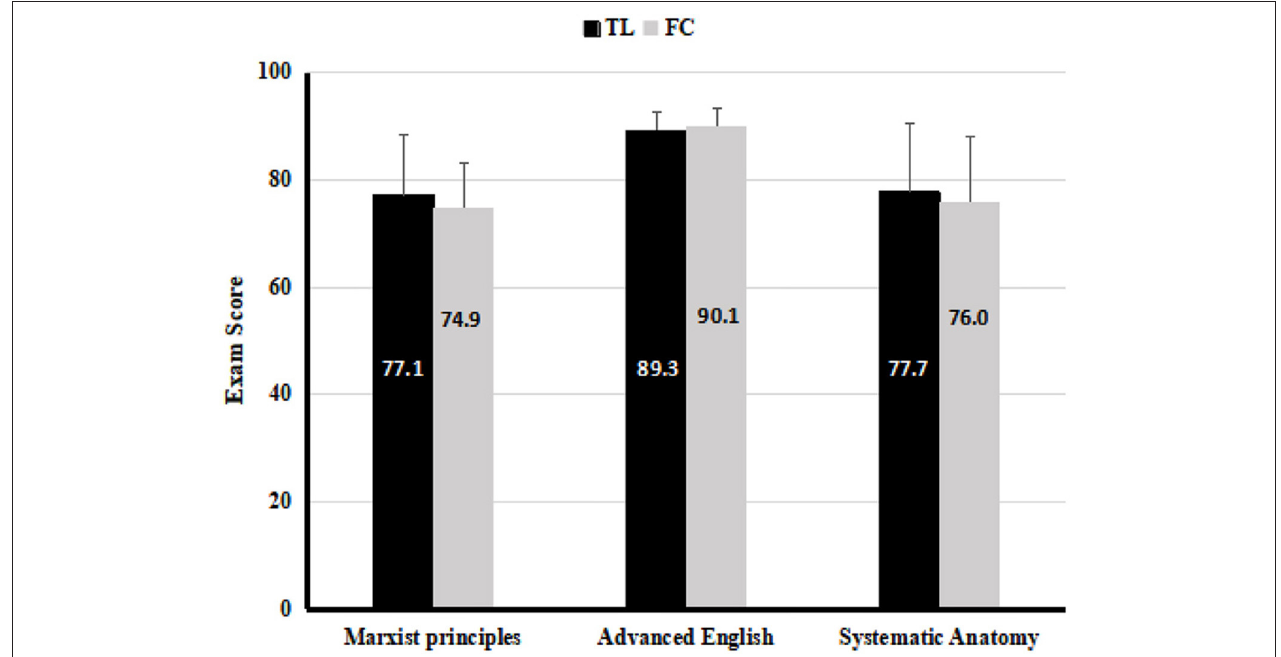
FIGURE 1 | The average exam scores of previous courses in the TL teaching class ( n = 61) and FC teaching class ( n = 58), analyzed by T -test. Values are means ±